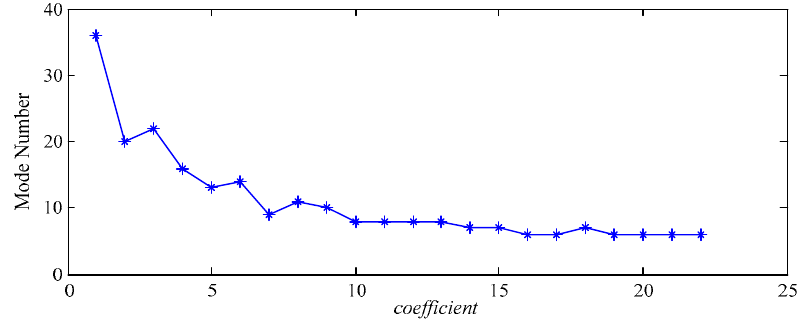
Figure 14. The distribution diagram of mode numbers based on loose slipper fault